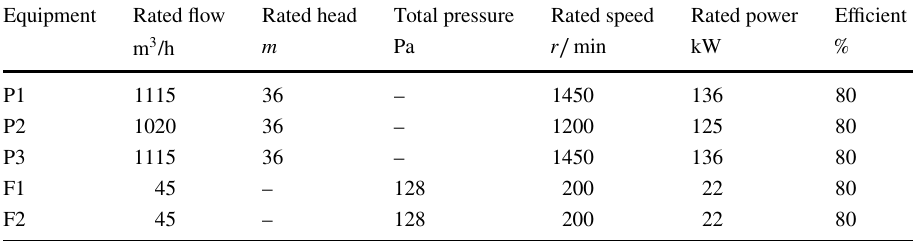
Table 4 Rated parameters of each device